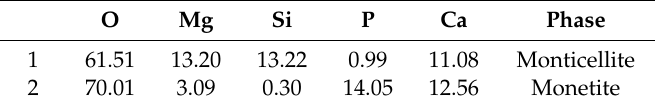
Table 7. EDS analysis (atom %) for directionally solidified rods grown at 50 mm / h after soaking in the SBF solution for 28 days.